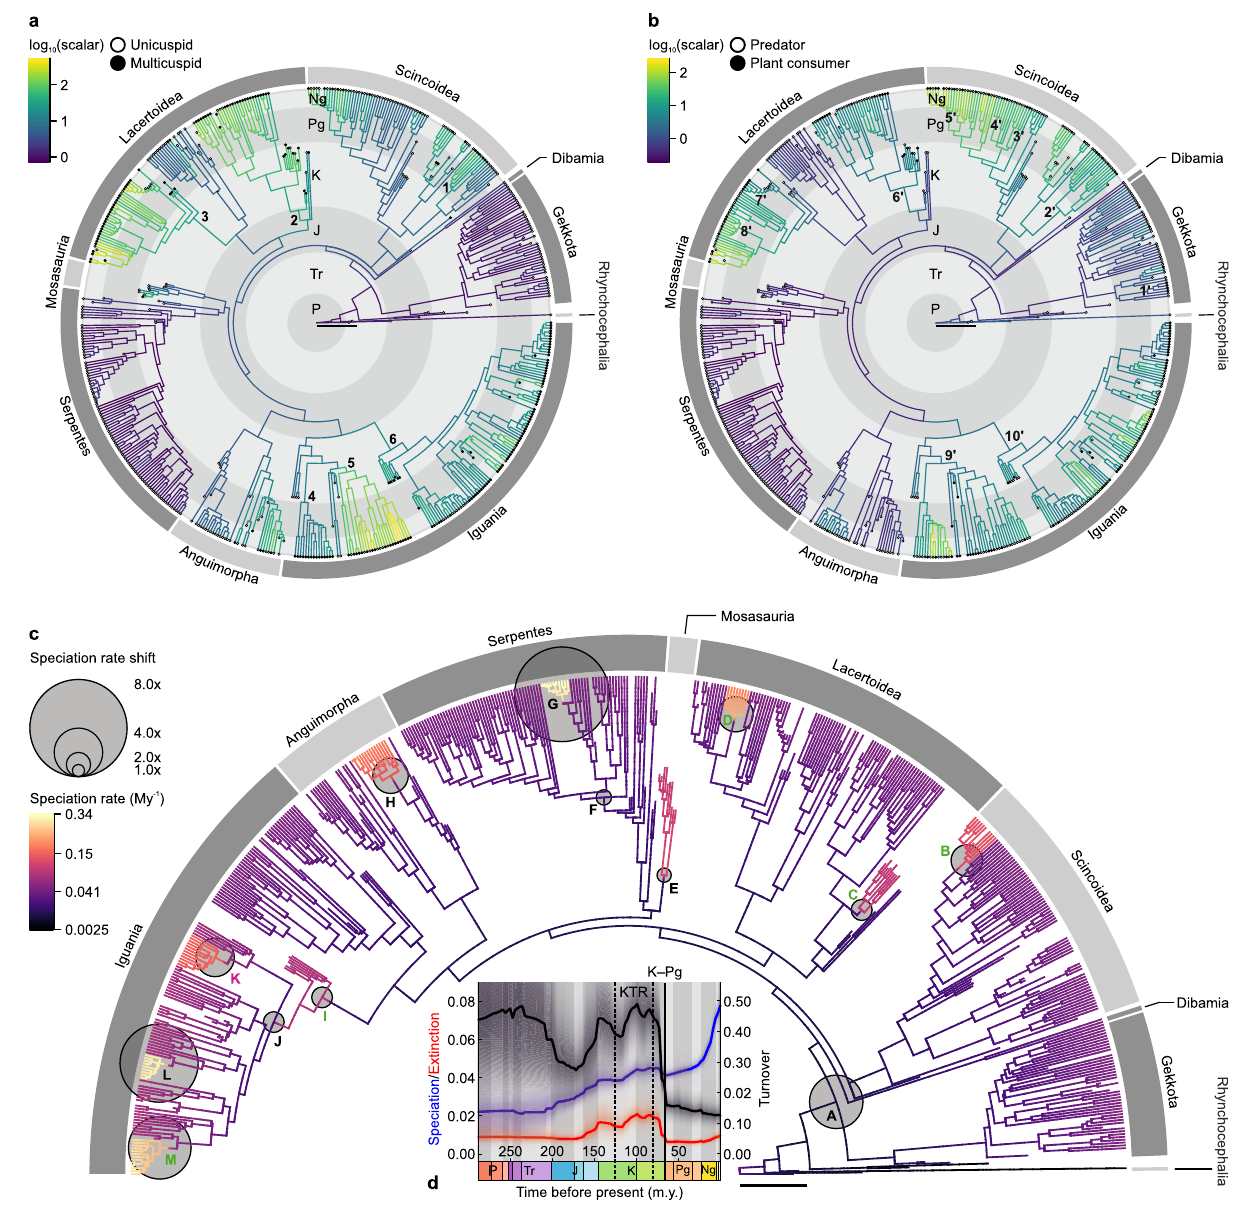
Fig. 4 Dental-dietary rates of phenotypic evolution and squamate diversi fi cation patterns. Log-transformed averaged rate scalars of the character transition rates of tooth complexity ( a ) and diet ( b ) across squamates. Positive values (i.e., rate scalar > 1) indicate increased relative transition rates. c Rates of squamate speciation for one maximum shift credibility con fi guration (MSC) out of ten similar independent replicates. Thirteen rate shifts (A – M) present in at least fi ve MSC replicates are indicated proportionally to their magnitude compared to the background rate. d Mean rates of squamate speciation and extinction (in My − 1 ), and turnover (extinction/speciation) through time; see also Supplementary Fig. 10. Shaded areas: 95% con fi dence interval. 1: Gerrhosauridae (node 616; see Supplementary Fig. 1). 2: Teiioidea + Polyglyphanodontia (informally Teiioidea sensu lato , node 686). 3: